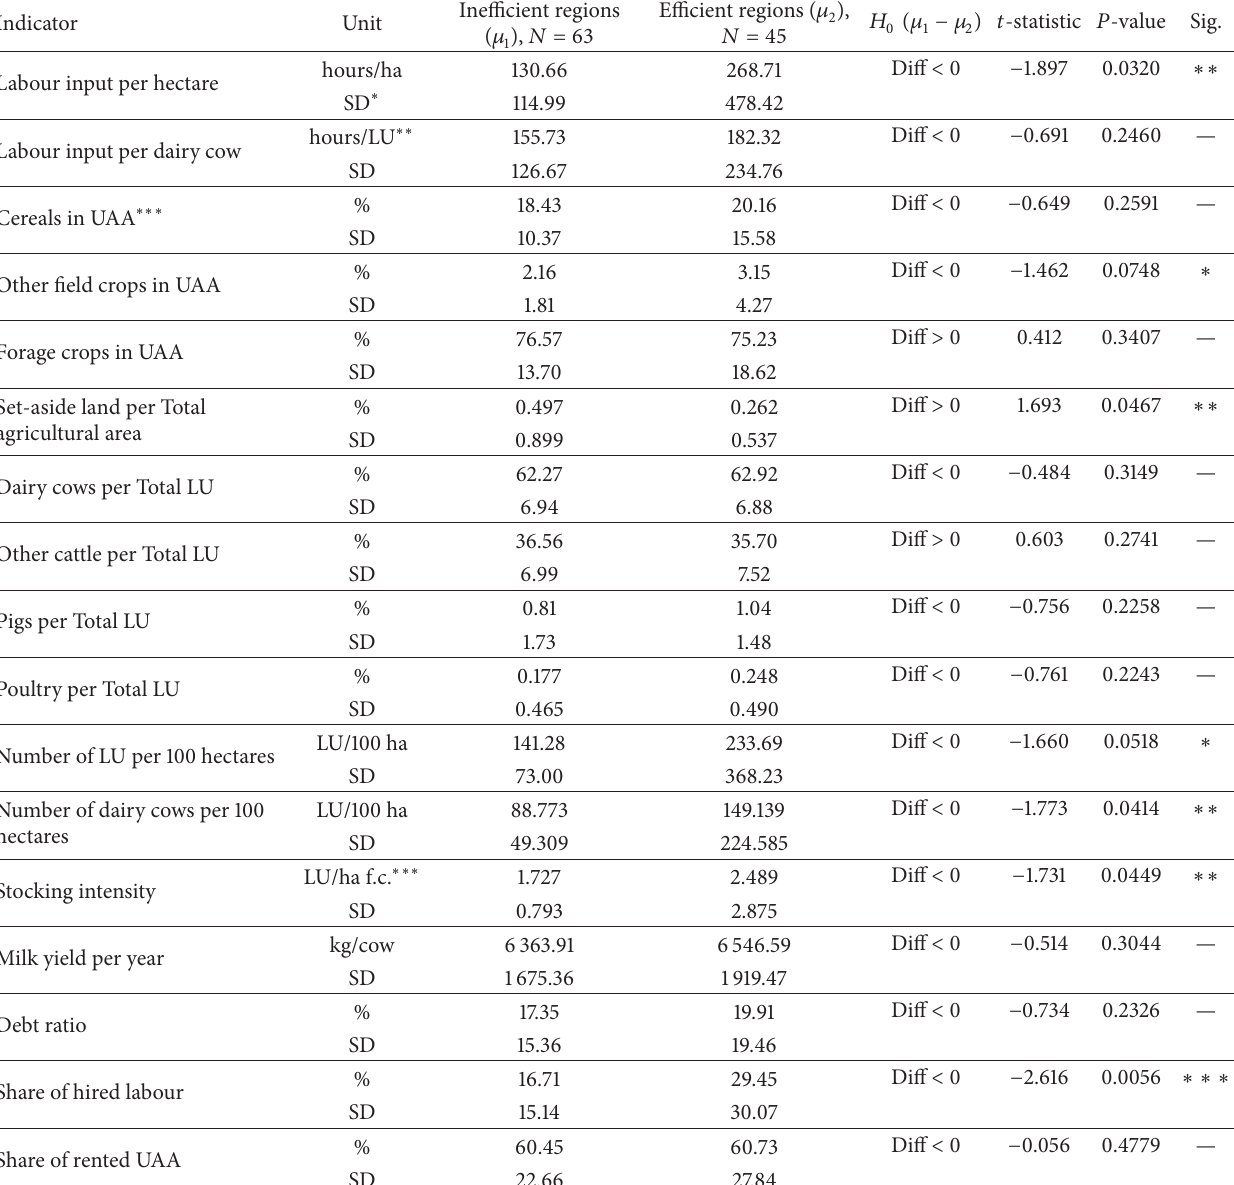
Table 8: Structural determinants of production efficiency in EU regions.